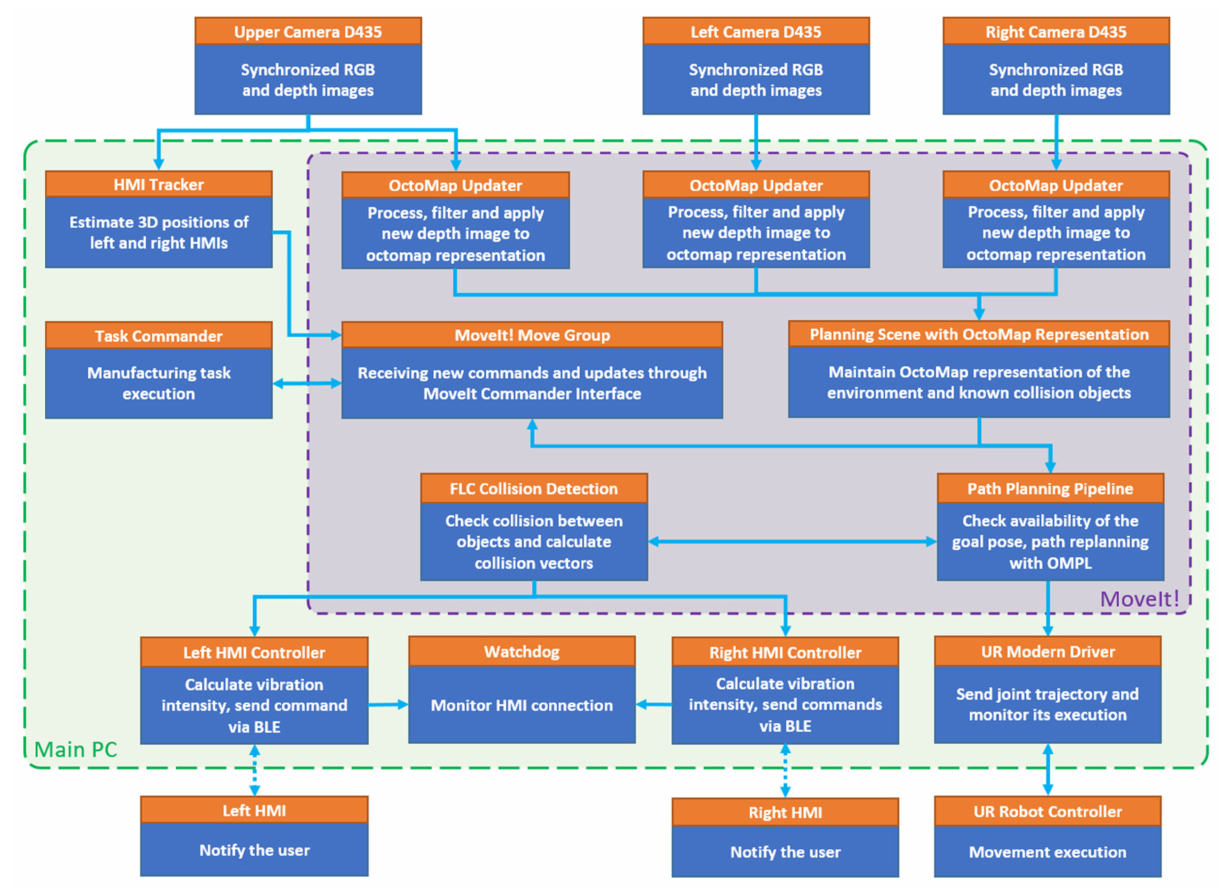
Figure 6. Data flow